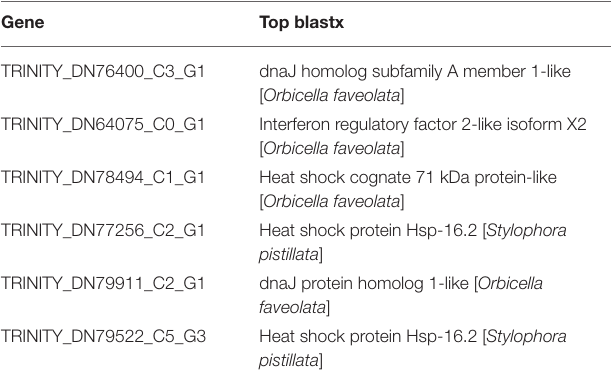
TABLE 3 | Gene information in the overrepresented GO term (GO:0009408, response to heat ) in coral Galaxea fascicularis . Gene Top blastx TRINITY_DN76400_C3_G1 dnaJ homolog subfamily A member 1-like [ Orbicella faveolata ] TRINITY_DN64075_C0_G1 Interferon regulatory factor 2-like isoform X2 [ Orbicella faveolata